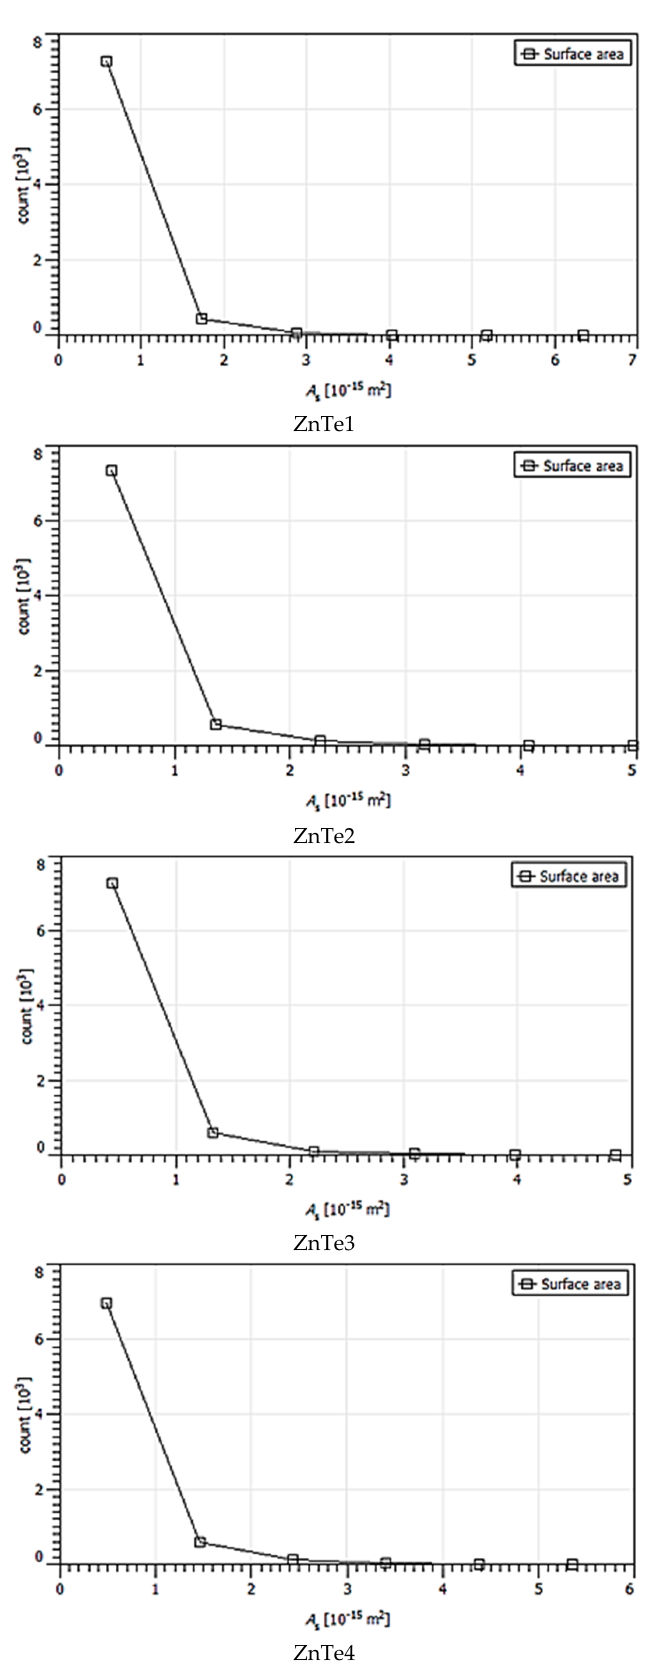
Figure 6. Surface area statistic variation of ZnTe1,2,3,4 thin films.